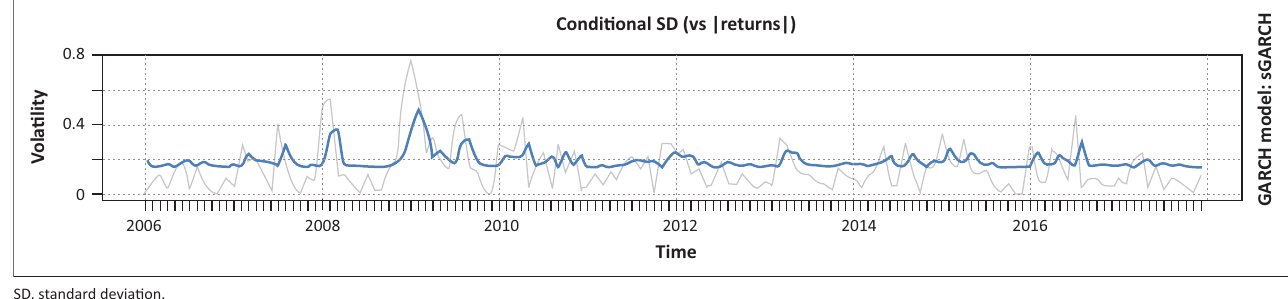
FIGURE 2: Volatility clustering results.